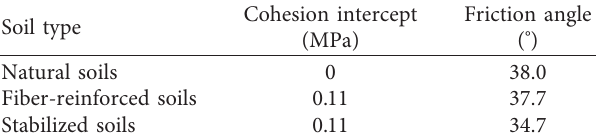
Table 5: Cohesion intercept and friction angle of